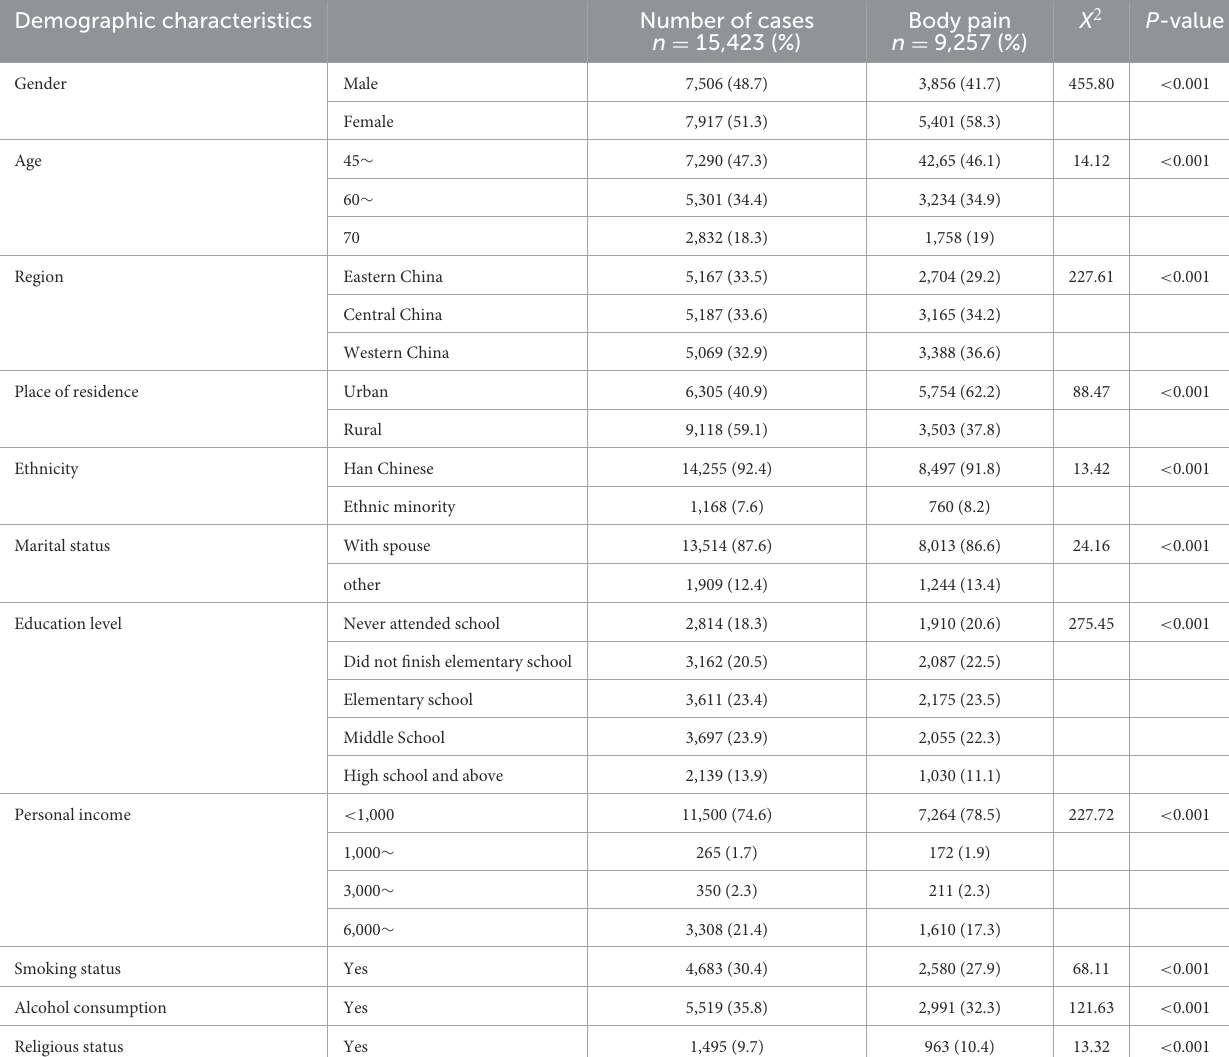
TABLE 1 Comparison of physical pain rates in 15,423 Chinese older adults. Demographic